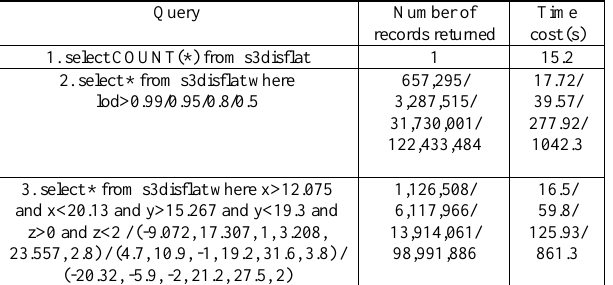
Table 1. Query performance on S3DISFLAT